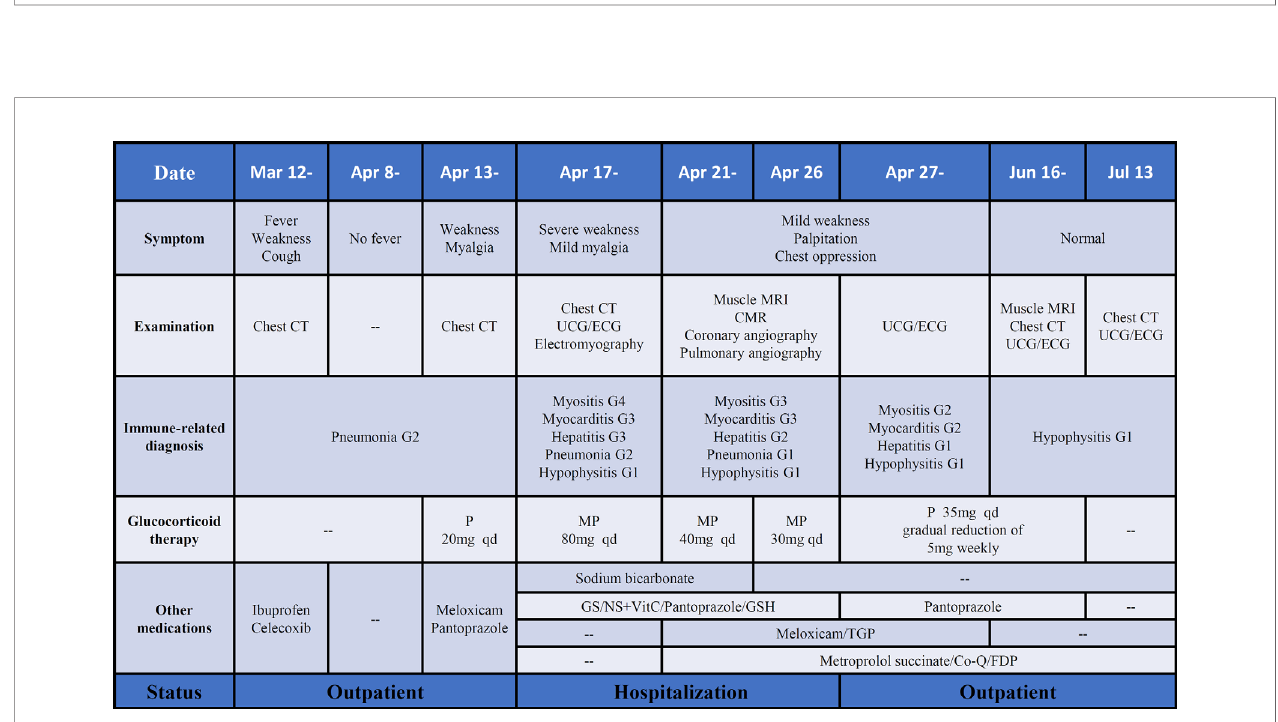
FIGURE 3 | (A) Muscle MRI of 5 weeks after immunotherapy: diffuse strip-shaped high-signal shadows were seen in the back and lower limbs, as indicated by the red arrows; (B) Muscle MRI of 10 weeks after immunotherapy: high-signal shadows receded after 40 days of glucocorticoid treatment, especially in the right lower limbs, as indicated by the red